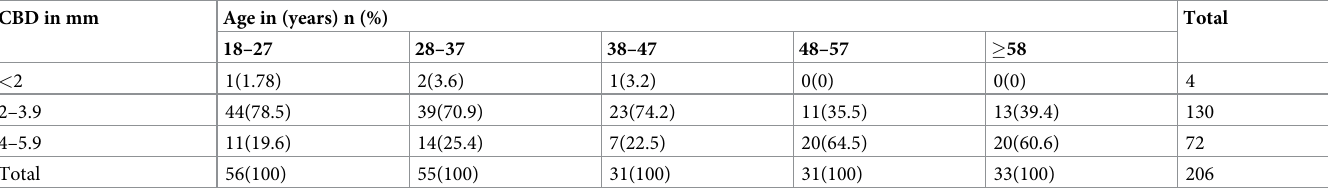
Table 1. Diameter of CBD stratified by age group, Northwest Ethiopia, 2019. CBD in mm Age in (years) n